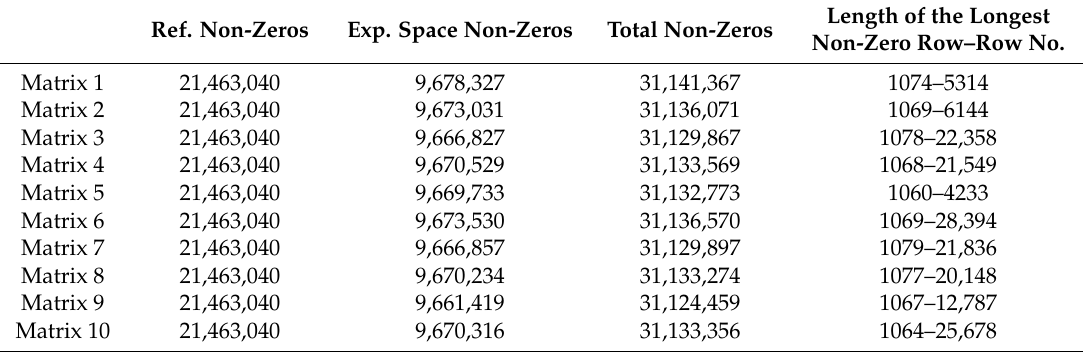
Table 3. The proposed storage format